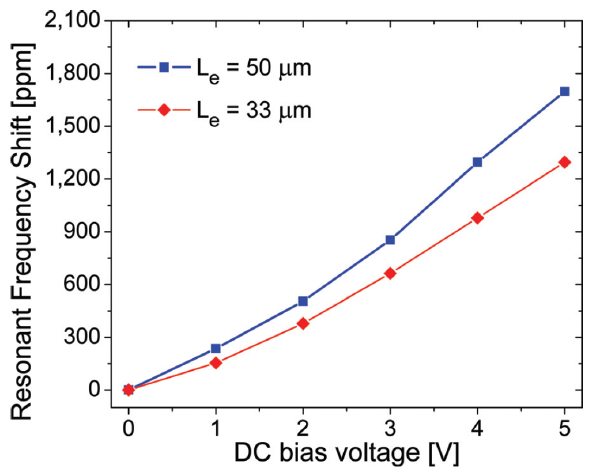
Figure 20. Measured resonant frequency shift of bridge resonators in response to the change in DC voltage applied to a PZT electrode with a length of 33 or 50 µ m [66]. Reprinted with permission from J. Vac. Sci. Technol. B, 30, Sviliˇci´c et al., Piezoelectrically transduced silicon carbide MEMS double-clamped beam resonators, c (cid:13) 2012, American Vacuum